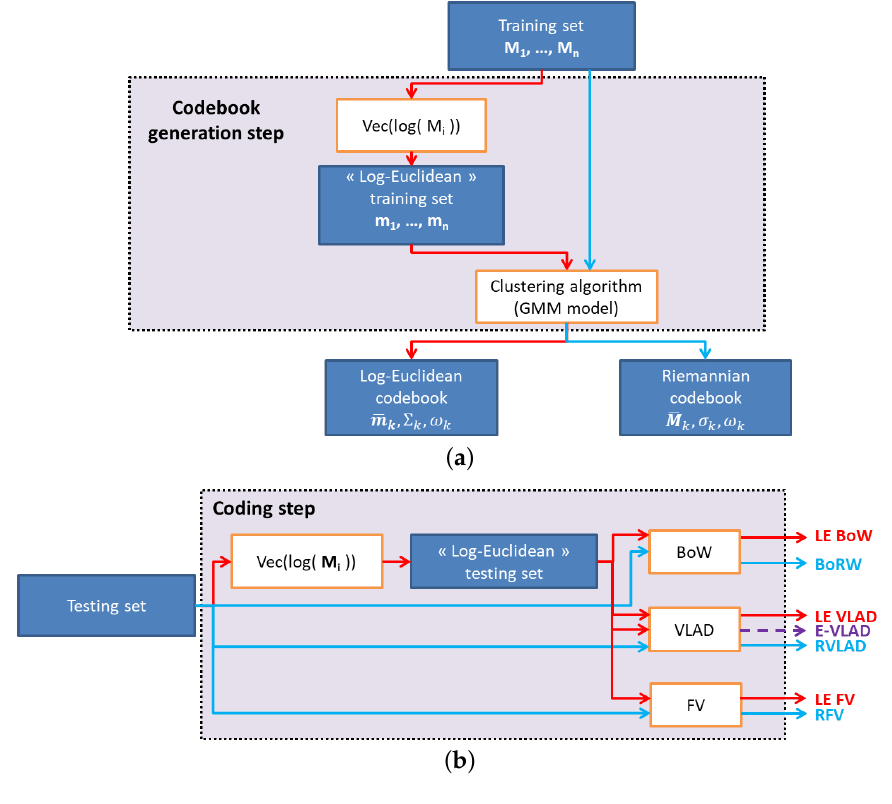
Figure 2. Workflow explaining ( a ) the codebook creation step and ( b ) the coding step. The LE-based approaches appear in red while the Riemannian based ones are displayed in blue. The E-VLAD descriptor is displayed in purple since it considers simultaneously a Riemannian codebook and LE vector representation of the covariance